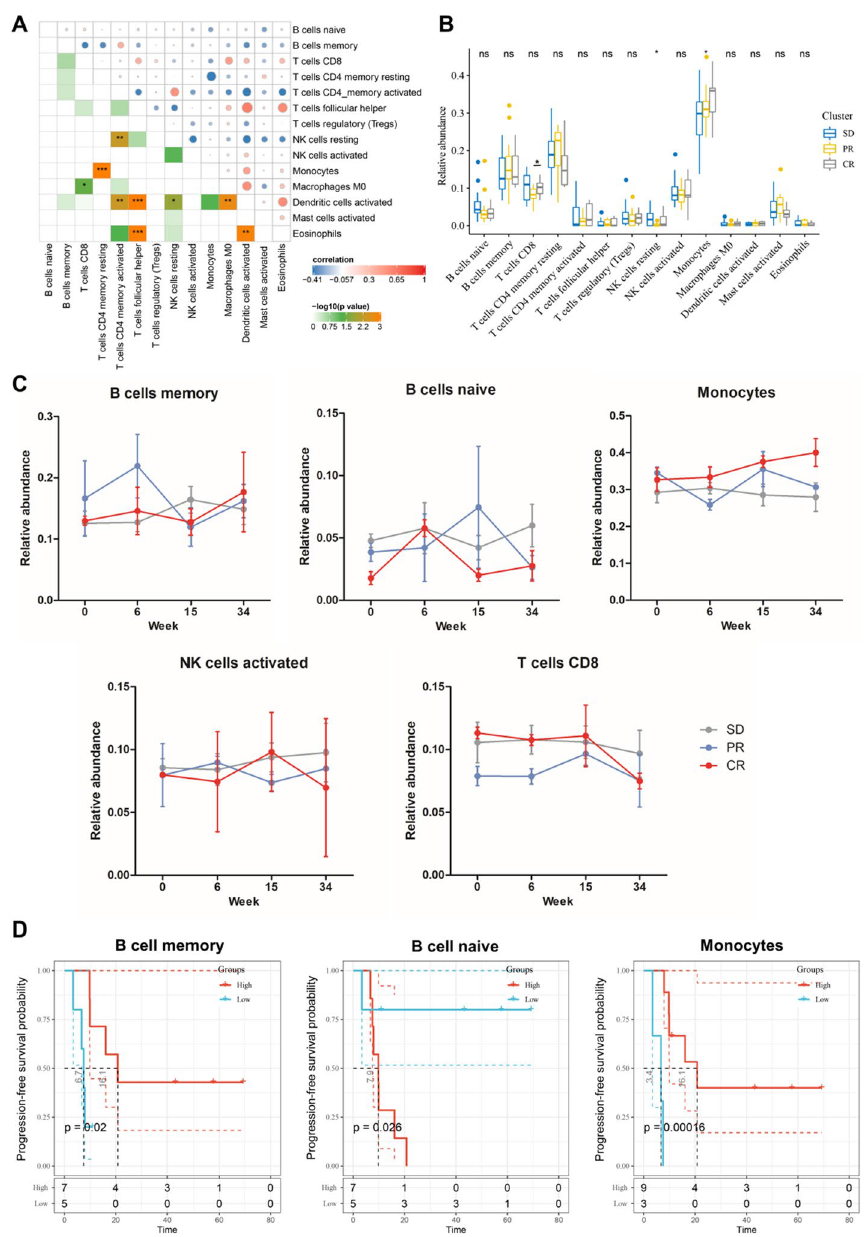
Fig. 1 Association of circulating immune cells with immunotherapeutic response and prognosis in LGG patients. a The interaction of circulating immune cells in LGG. Correlations are calculated by spearman correlation analysis. Positive correlation is indicated in red and negative correlation in blue. b The abundance of each circulating immune cells in SD, PR and CR patients. The upper and lower ends of the boxes represented interquartile range of values. The lines in the boxes represented median value, and dots showed outliers. c Average ( SD) abundance of B cell memory, B cell naive, Monocytes, NK cell activated and T cell ± CD8 (y axis) from week 0 to 34 (x axis). Response groups are indicated by color. d Kaplan–Meier curves for PFS showing the association between relative abundance of B cell memory, B cell naive, Monocytes and PFS (log-rank test, p < 0.05). * P < 0.05, ** P < 0.01, *** P <